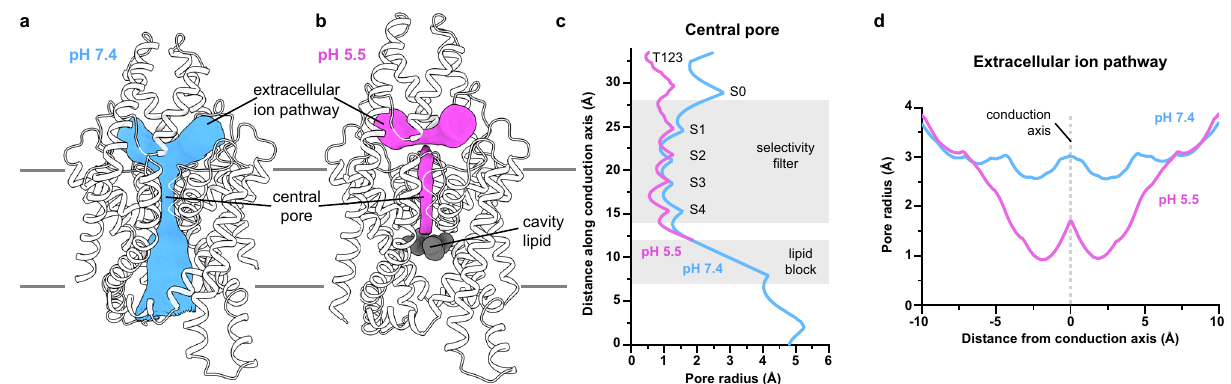
Fig. 2 TWIK1 conduction pathways at high and low pH. a , b Structures of TWIK1 at ( a ) pH 7.4 and ( b ) pH 5.5 with the surface of conduction pathways shown in gray. c Radius of the central pore as a function of distance along the conduction pathway. Positions of the selectivity fi lter, lipid block at low pH, K + coordination sites S0-S4, and T123 are indicated. d Radius of the extracellular ion pathways as a function of distance from the central